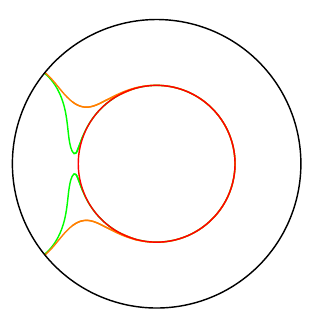
Figure 5. A subdominant saddle (in green) and the minimal surface (in orange), d = 4, g = (cid:12) = G = 1, (cid:13) = (cid:0) 0 : 1 and (cid:22) = 2 :